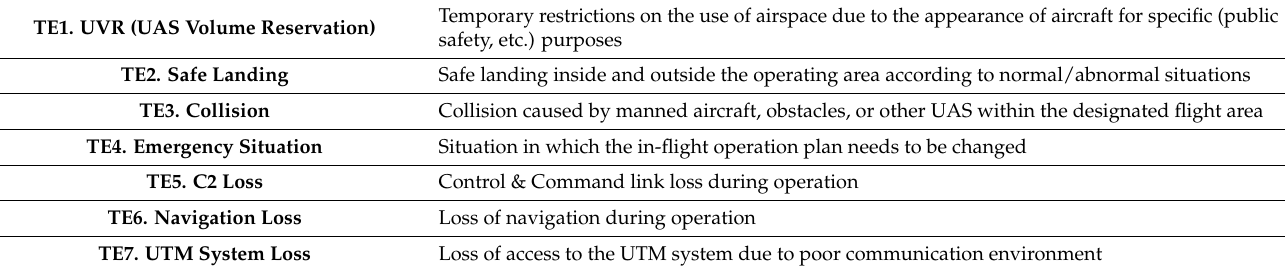
Table 3. Test Events